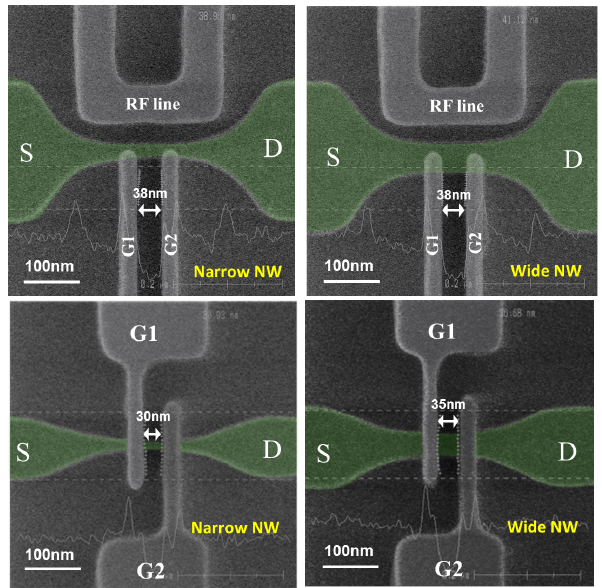
Figure 2. Examples of samples after gate patterning. Active (resp. gate) area is represented in green (grey) color. Multi-gate devices are realized with a 65nm gate pitch.